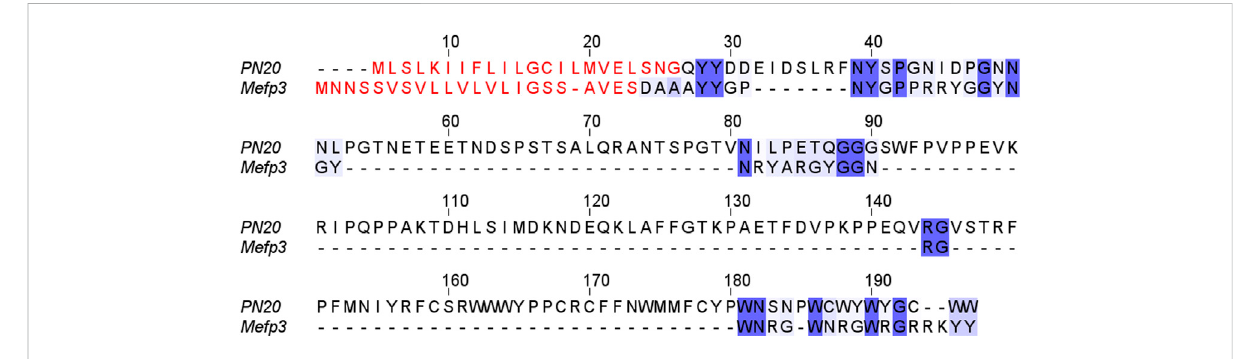
FIGURE 7 Comparison of P. conspersa PN20 and Mytilus edulis Mefp3. Signal peptides labelled with red letters; identical/similar amino acids highlighted by shades of blue. Noticeably, a substantial proportion of the identities/similarities is represented by aromatic amino